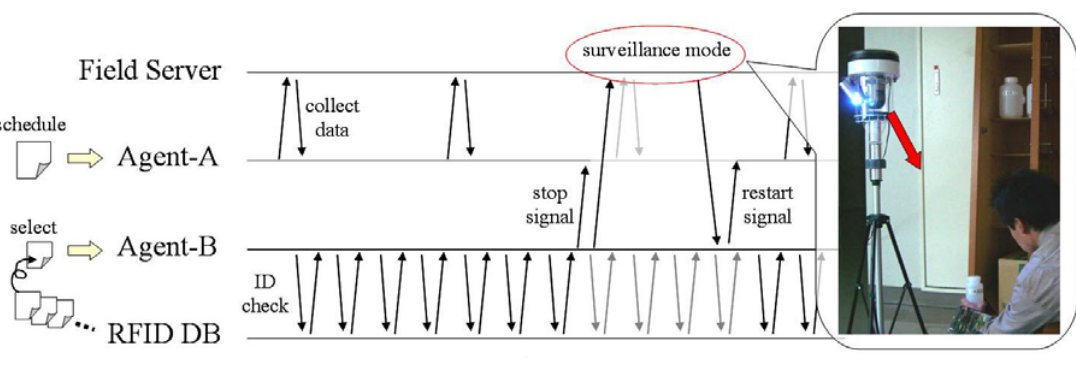
Figure 9. Operation status flow of Agent System.